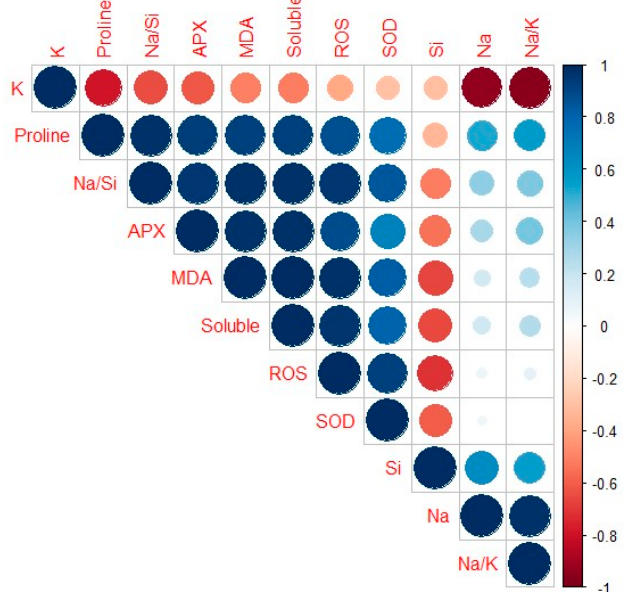
Figure 7. The relationship between different parameters in response to chitosan treatment under salt stress. ROS: reactive oxygen species (H 2 O 2 ); MDA: malondialdehyde; Soluble: total soluble sugars; APX: ascorbate peroxidase; SOD: superoxide dismutase; Na: sodium ion; K: potassium ion, Si: silicon ion; Na/K: Na + /K + ratio; Na/K: Na + /K + ratio. The color of the circles and the coefficient values refer to the strength and significance of the correlation: 0.75–1 = strongly correlated; 0.5–0.75 = highly correlated; 0.25–0.50 = moderately correlated; and 0–0.25 = weekly correlated. Under 0 = negatively correlated.